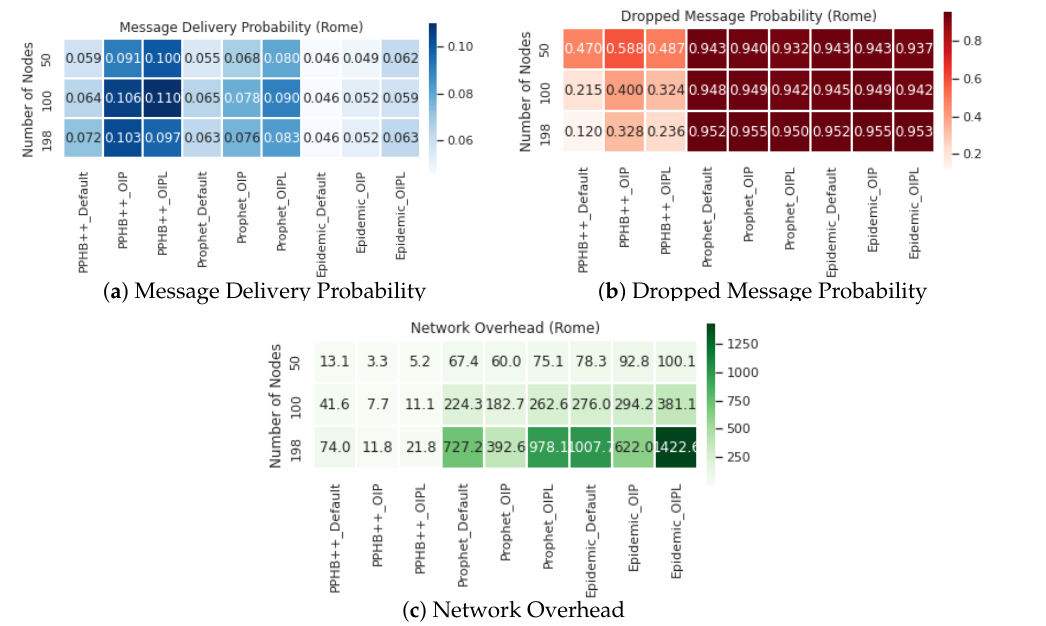
Figure 10. Comparison of ONE default setting with optimized parameters for Rome dataset (The MDP and DMP parameters are normalized to a scale between 0 and